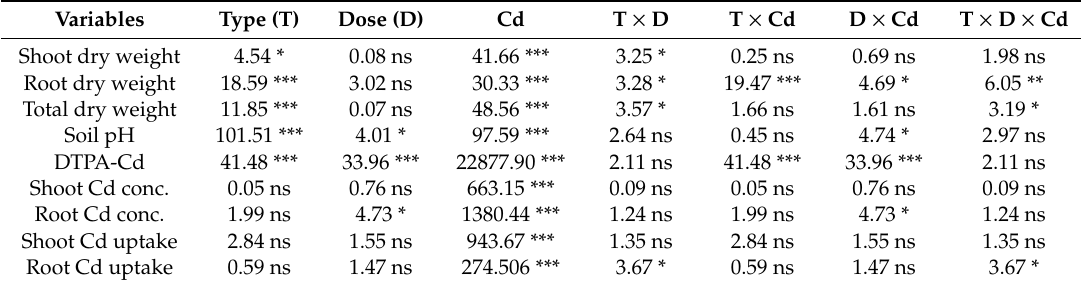
Table 3. E ff ects of MP type, MP dose, Cd, and their interactions on measured variables based on a three-way ANOVA analysis. Significance level ( F value): * p < 0.05, ** p < 0.01, *** p < 0.001; ns: nonsignificant e ff